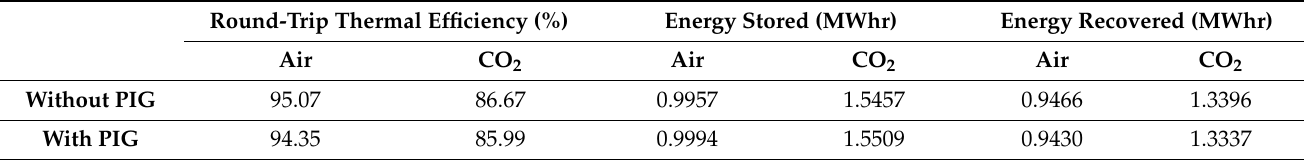
Table 7. Round-trip thermal efficiency, energy stored and recovered for air and CO 2 while considering the accumulator set-up with and without the pipeline inspection